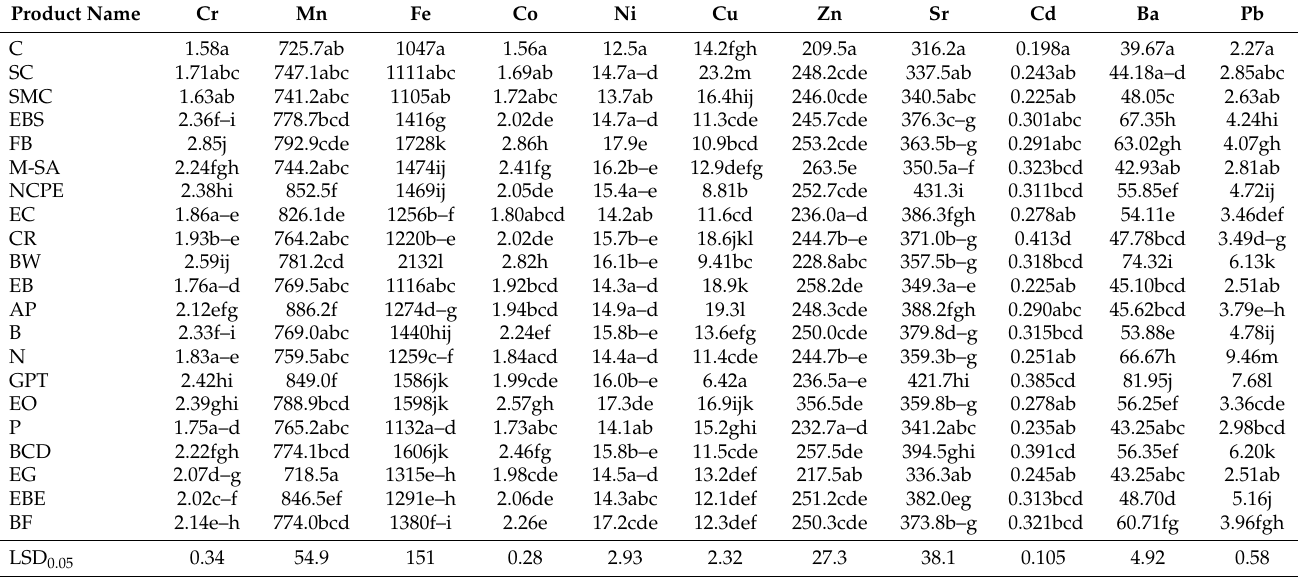
Table 5. Quantities ( µ g/L) of eleven micro elements (Cr, Mn, Fe, Co, Ni, Cu, Zn, Sr, Cd, Ba, and Pb) in white wine samples treated with twenty-one bentonite products including control treatments (Debrecen-Pallag, Hungary). Different letters within each column are significantly different among the bentonite product treatments at p = 0.05 according to LSD t-tests (LSD 0.05 ). Explanations for bentonite product name abbreviations are given in Table 1. Order of used letter for significance differences: a, b, c, d, e, f, g, h, i, j, k, l,